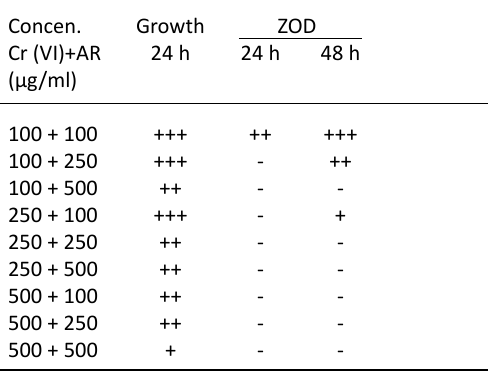
Table 1B. Effect of varying concentration concomitant Cr(VI) and AR on growth and ZOD in TSA media